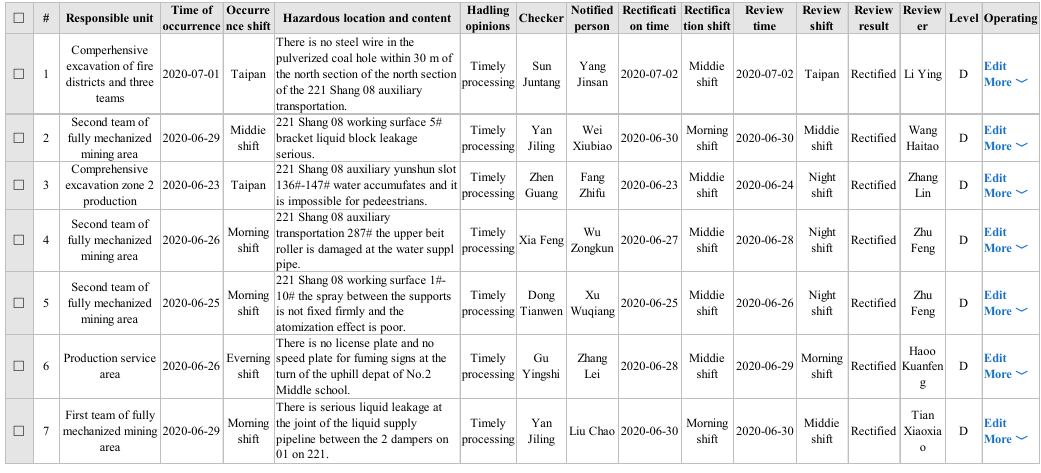
Figure 4. Risk data (partial data).